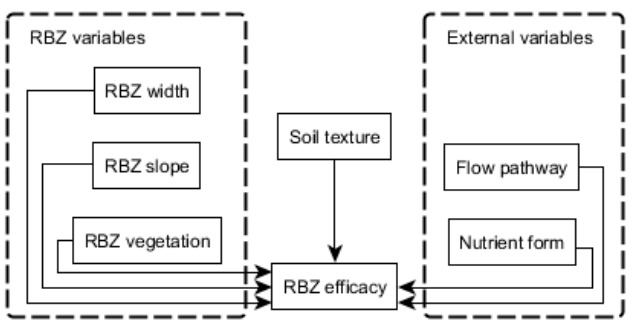
Figure 2. BN structure with nodes and links. We assumed that the reported soil textures are similar in the RBZ and their catchments.